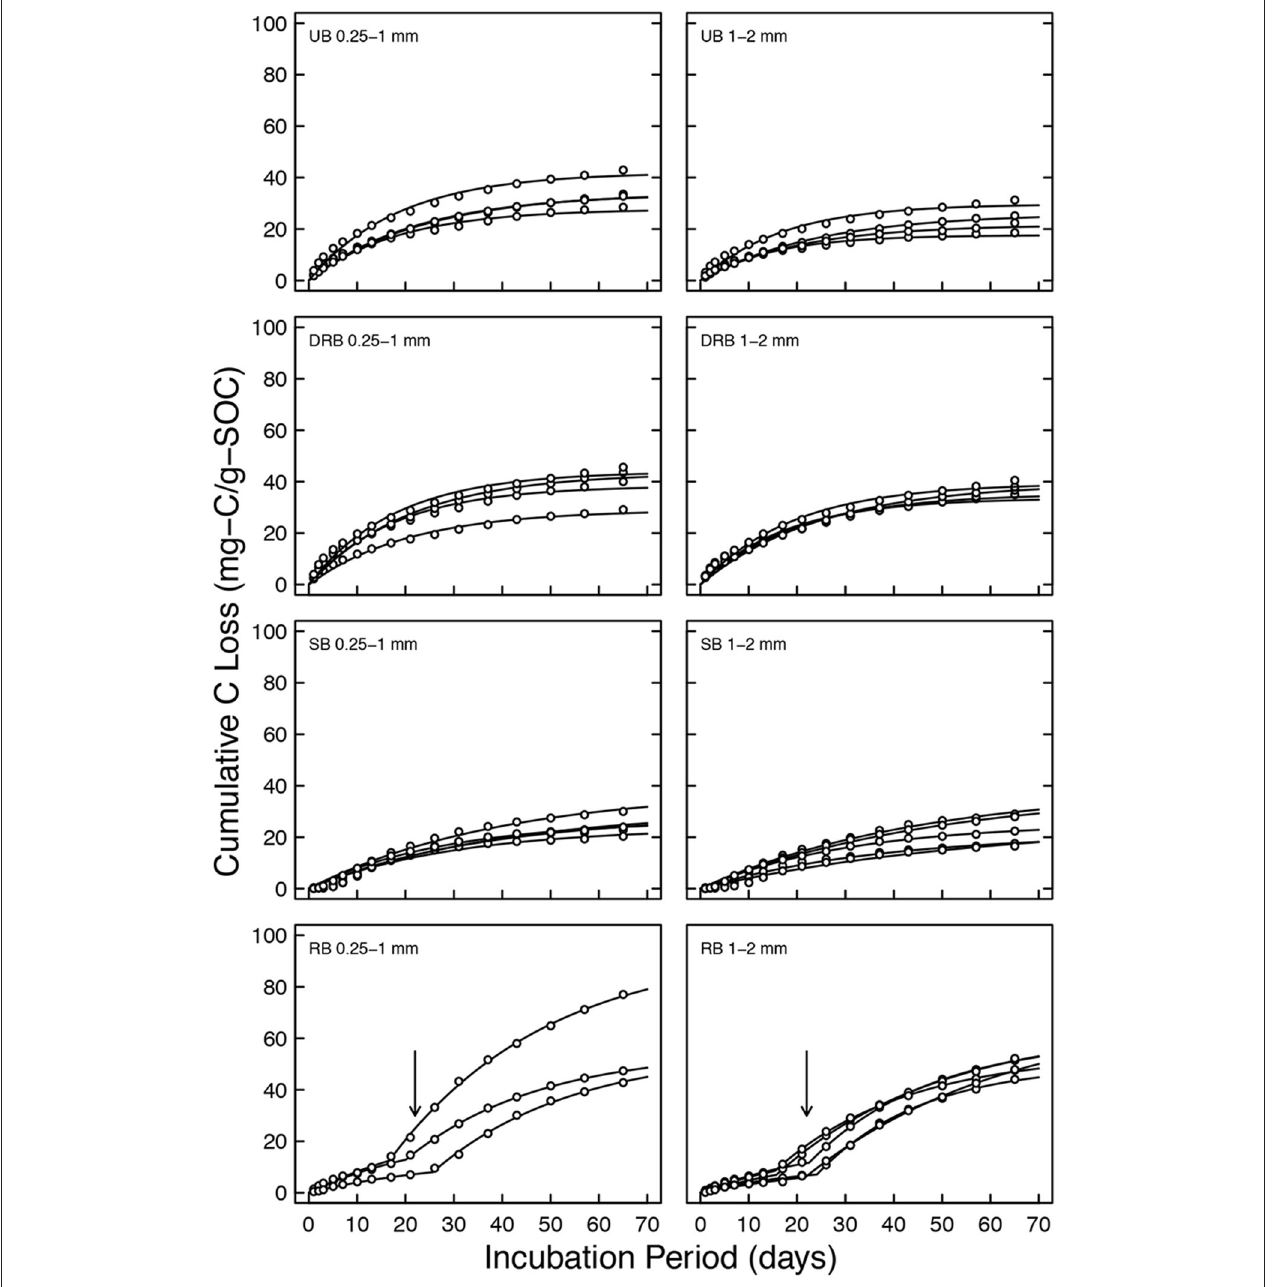
FIGURE 4 | Cumulative CO 2 -C loss in µ gC g soil − 1 for forest soil with aggregate sizes of 0.25–1 and 1–2mm. Solid lines are model fits. Arrows indicate delayed onset of rapid